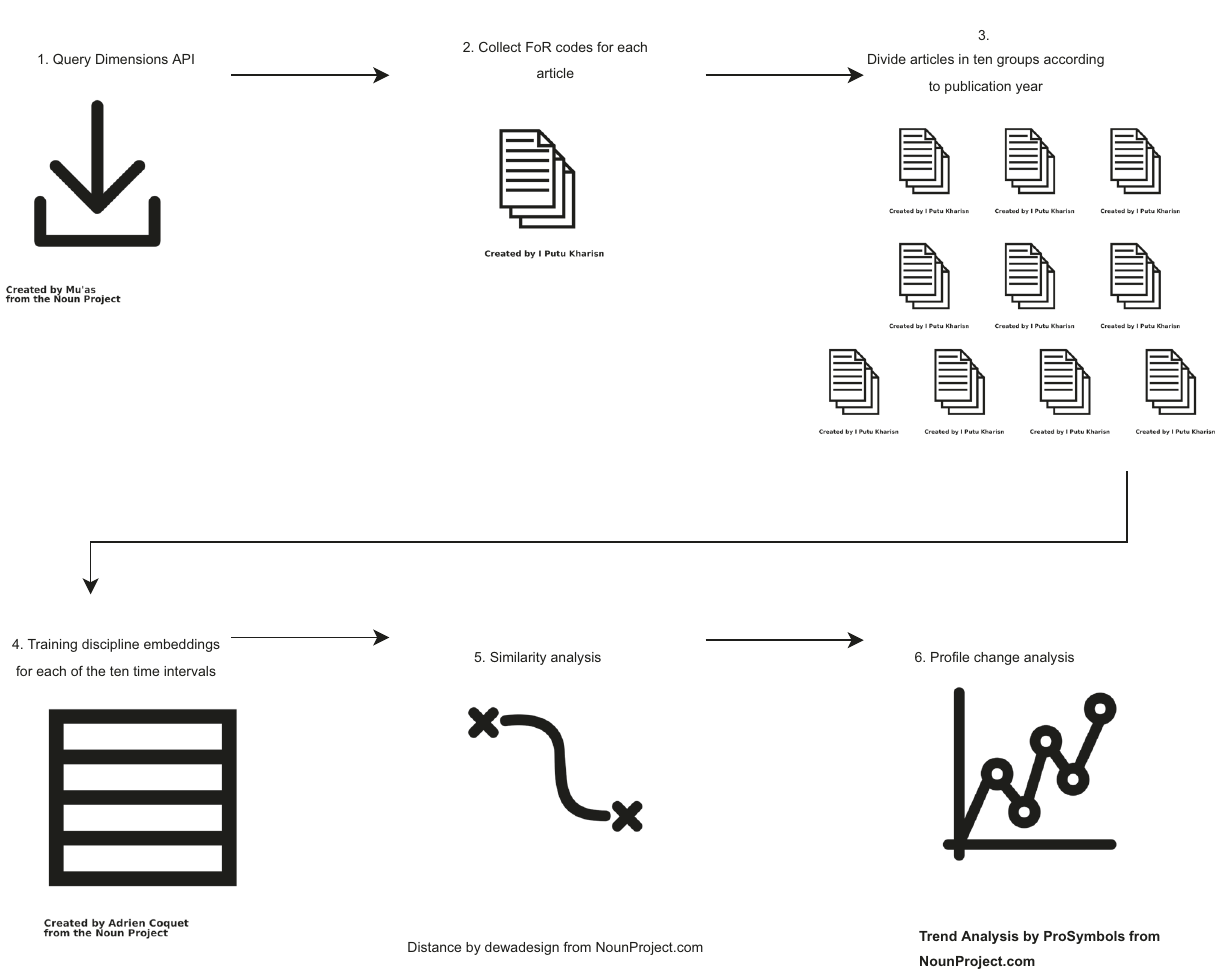
Fig. 5 Data extraction, processing, and analysis steps of this